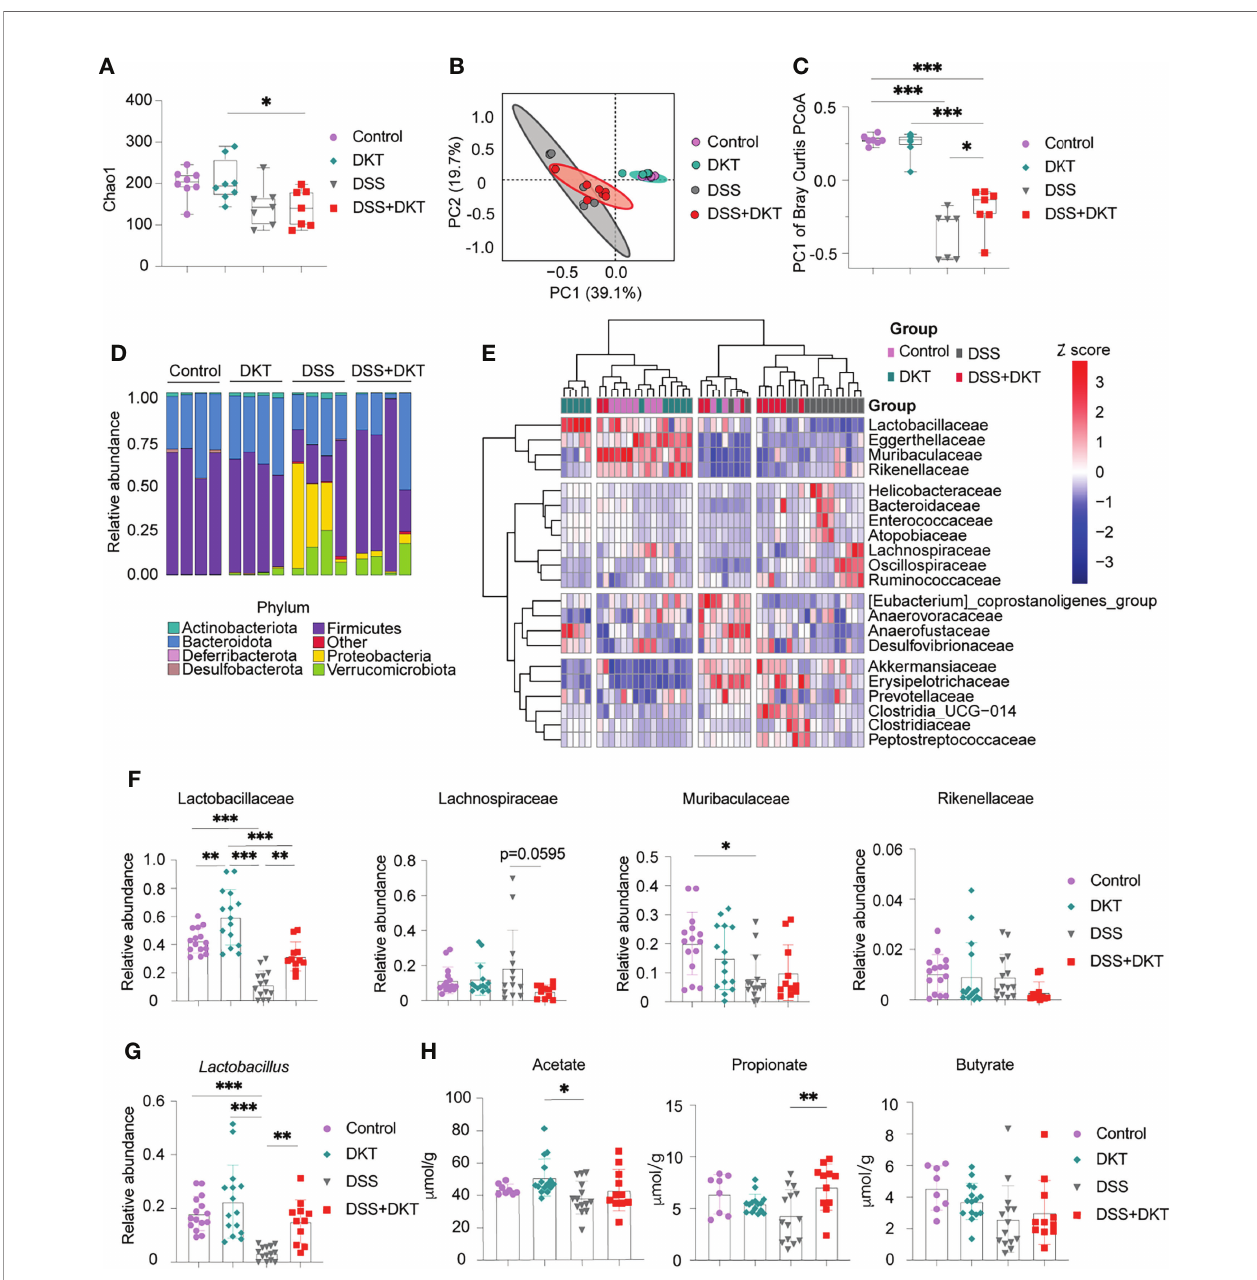
FIGURE 2 | DKT alters the colonic microbiota composition and metabolites in DSS-induced acute colitis. (A) Chao1 alpha diversity of the colonic microbiota on day 15 (Control N=8, DKT N=8, DSS N=7, DSS+DKT N=7). (B) Principal coordinates analysis (PCoA) of the Bray Curtis distances between samples; day 15 samples are shown (Control N=8, DKT N=8, DSS N=7, DSS+DKT N=7). The ellipses indicate 95% con fi dence levels for the four groups. (C) PC1 of the Bray-Curtis PCoA among the four groups (Control N=8, DKT N=8, DSS N=7, DSS+DKT N=7). (D) The bacteria composition in the colonic contents at the phylum level on day 15 (N=4 per group). (E) Heatmap showing the top 21 highly abundant family-level bacteria on day 15 among the four groups. The microbial composition data at the family level were scaled and clustered based on the Ward-linkage method (Control N=11, DKT N=12, DSS N=14, DSS+DKT N=11). (F) Relative abundance of the family-level bacteria Lactobacillaceae, Lachnospiraceae, Muribaculaceae and Rikenellaceae on day 15 are shown (Control N=15, DKT N=15, DSS N=14, DSS+DKT N=11). (G) Relative abundance of the genus-level bacteria Lactobacillus on day 15 among the four groups (Control N=15, DKT N=15, DSS N=14, DSS+DKT N=11). (H) The concentration of three short-chain fatty acids (SCFAs), acetate, propionate and butyrate, on day 15 in the colonic contents are shown (Control N=8, DKT N=15, DSS N=14, DSS+DKT N=11). The SCFAs were measured by a GCMS platform. Results are pooled from two or three independent experiments with three to fi ve mice in each experimental group. Each symbol (A – C and F – H) represents data from an individual mouse. Graphs (A, C , and F – H) display means ± SEM; *p<0.05, **p<0.01, and ***p<0.001. Statistical analysis was performed using One-way ANOVA with Tukey ’ s multiple comparisons